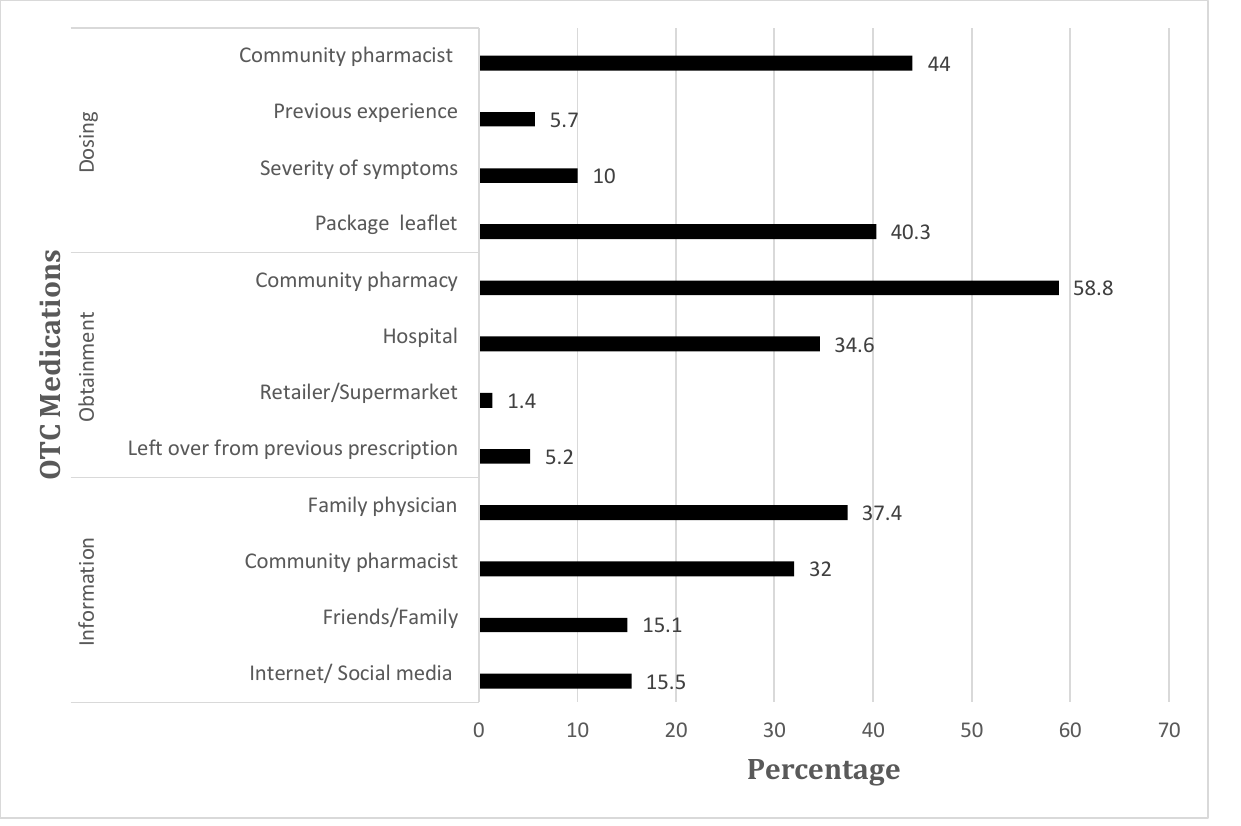
Figure 1. Sources of information, obtainment, and dosage of OTC medications.